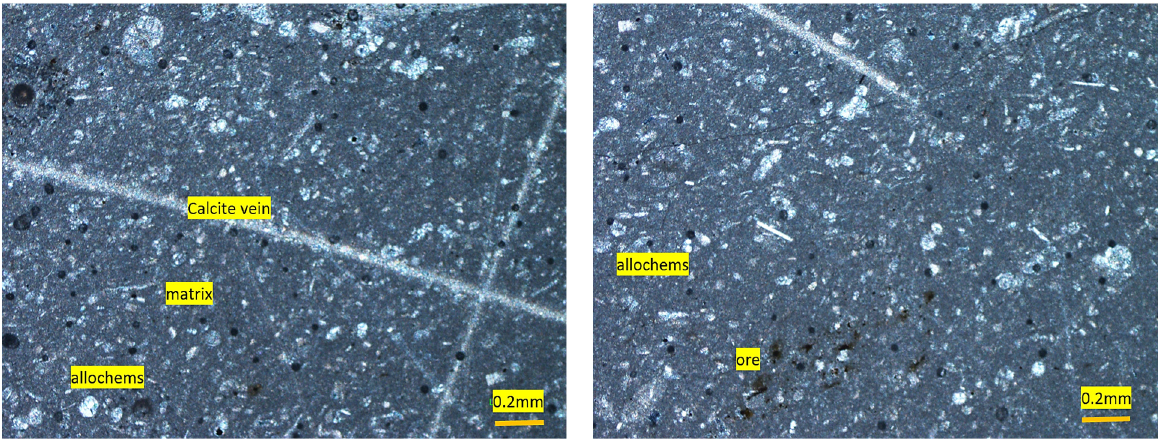
Figure 6. Photomicrographs of wackstone (Bioclastice limestone) showing allochems (Bioclasts) and lime-mud matrix (Abbottabad aggregate).